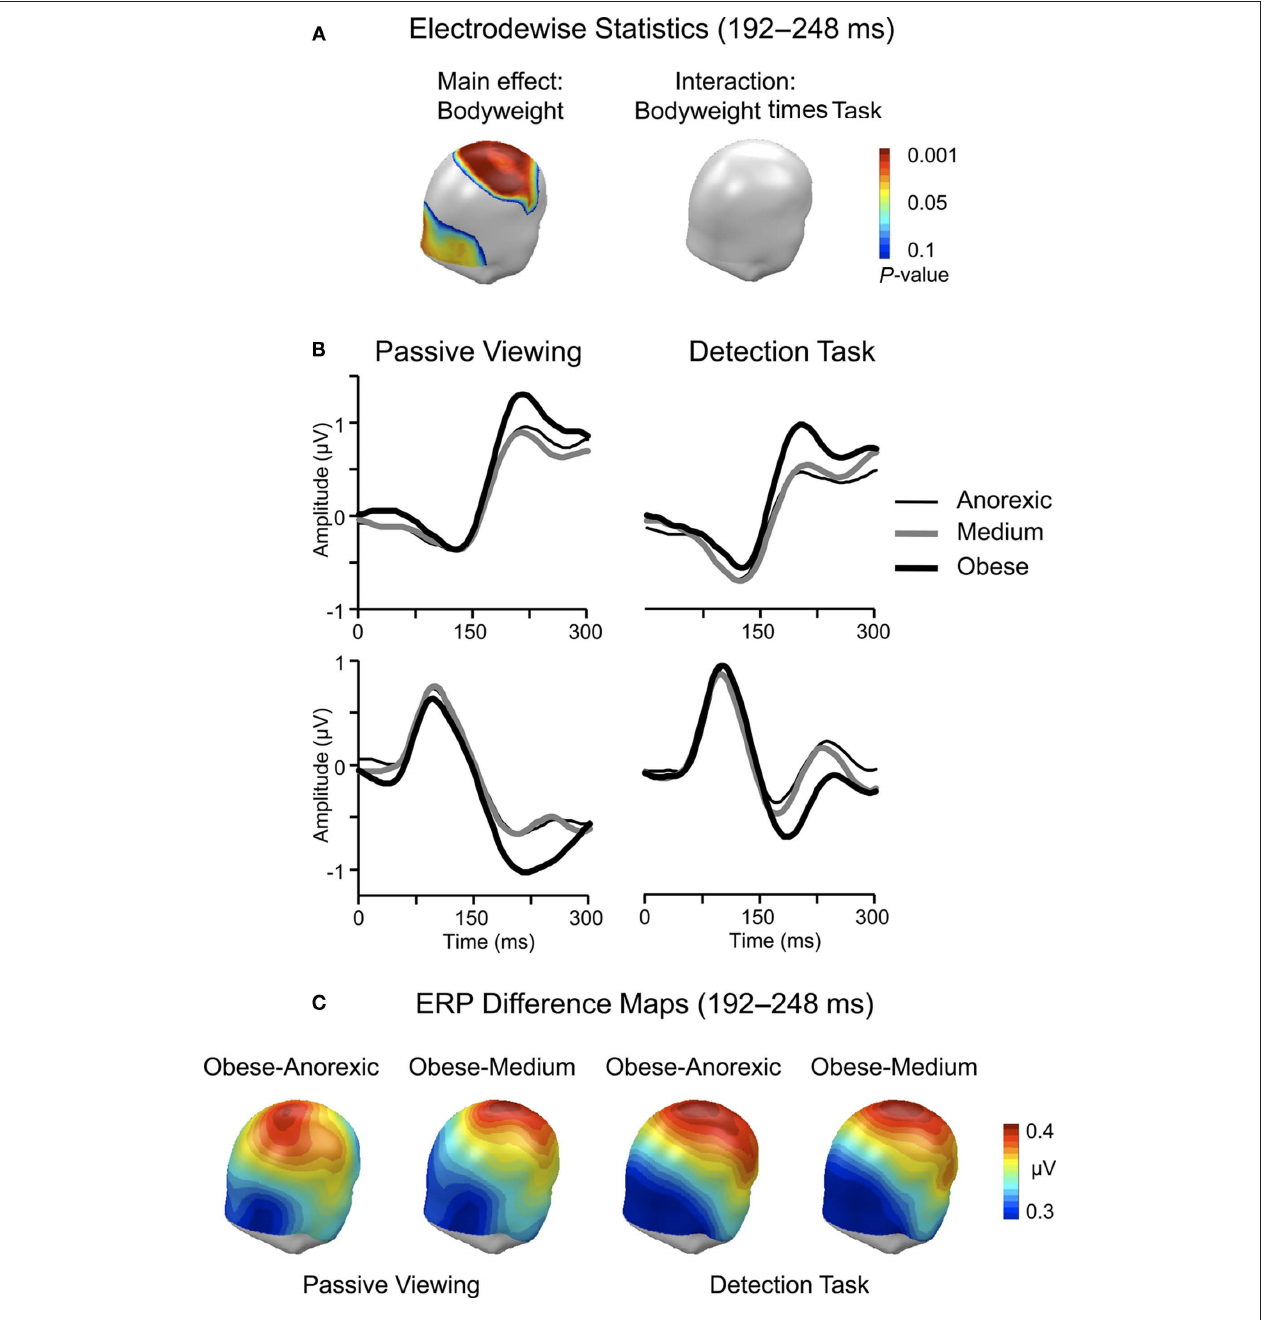
viewing and active task conditions for representative right central (#132) and occipito-temporal (#175) sensors. (C) Illustration of the topographical distribution of the original scalp potentials. A back view of a model head is displayed.